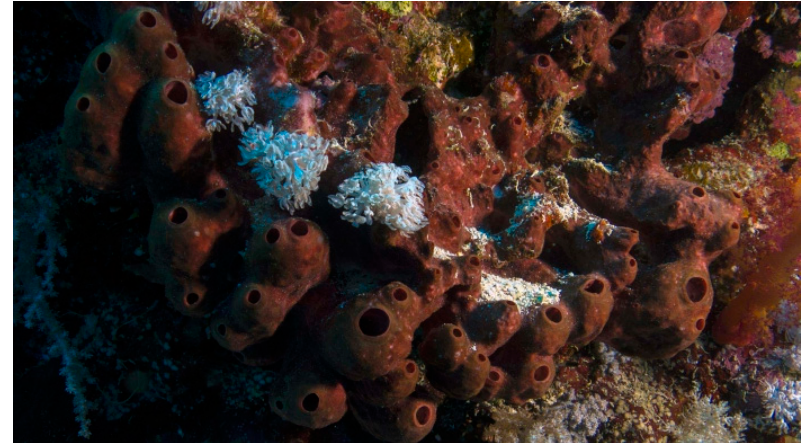
Figure 8. Image of a colony of Theonella swinhoei demosponges; http://www.marinespecies. org/aphia.php?p=image&tid=171264&pic=133237. Licensed under a Creative Commons Attribution- Share Alike